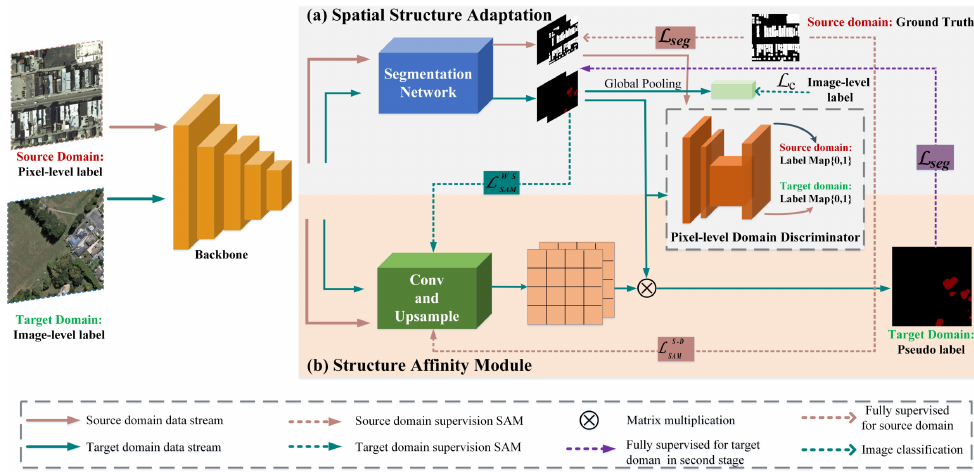
Figure 2. Illustration of the CDSA architecture. To tackle the challenges of domain shifts and ambiguous boundaries in remote sensing building images, ( a ) SSA extracts domain-invariant features and simultaneously infuses the structure affinity of the source domain into the target domain by aligning the spatial structure feature distribution. ( b ) SAM learns the affinity matrix by mining structure affinity from the ground truth in the source domain and predicted results in the target domain. Then, the learned affinity matrix is applied to refine the initial predicted results obtained by